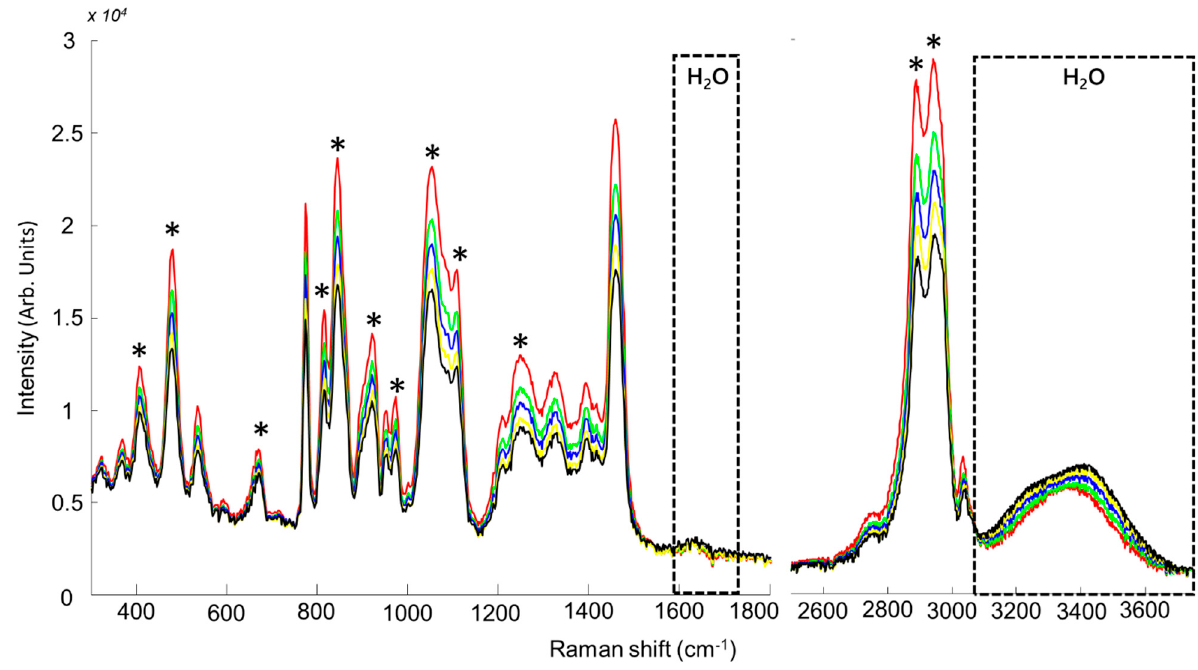
Figure 3. Mean Raman spectra for BG samples. Concentrations for water are respectively 0% (red), 9.085% (green), 16.655% (blue), 23.075% (yellow), and 28.56% (black). * Indicates bands corresponding to glycerol. The dotted boxes indicate the positions of H 2 O features.